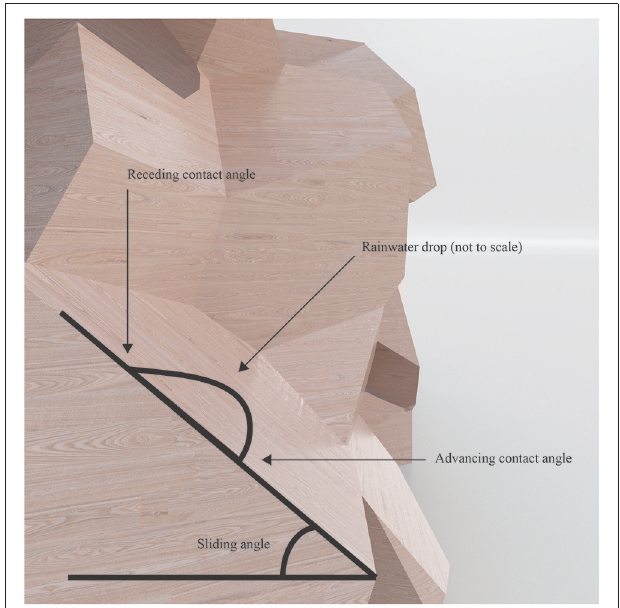
FIGURE 11 | The building envelope faces identified as optimally carrying Panel C façade